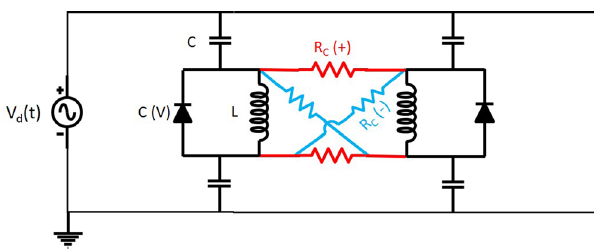
Fig. 1 Pairwise oscillator coupling. The main idea of coupling between nodes is illustrated here using a pair of oscillators, each consisting of a varactor diode, with capacitance C(V), and an inductor, L , in parallel. These are driven via capacitors, C d , to induce subharmonic oscillations, for which ω = ω d /2. The two oscillators can be either positively coupled using the resistor pair labeled R c ( + ) (red), or negatively using the resistor pair labeled R c ( − ) (blue). The oscillations across each oscillator ’ s diode/ inductor are measured as a fl oating voltage. driving signal via a pulse generator and digitize the voltage pro fi les at all eight oscillators. The coupling scheme is illustrated in greater detail in Fig. 2b, which shows the example of a negative coupling between oscillator 1 and 3. There are eight inputs to the module arranged vertically on the left (three of which are depicted), and 16 used outputs arranged horizontally at the bottom (again three are shown). The fi rst eight outputs (not shown) are responsible for positive coupling between oscillator pairs, and the next eight outputs (three shown) are responsible for the negative coupling. The latter is accomplished by crossing the wire at the bottom before feeding it back in to the respective oscillator. By closing that particular switch-pair (see solid circles), oscillators 1 and 3 are connected in the same manner as represented by the blue resistors in Fig. 1. While any oscillator pair can be independently coupled (either positively or negatively) in this way, note that this scheme does not allow for individual pairs to have different coupling strengths.